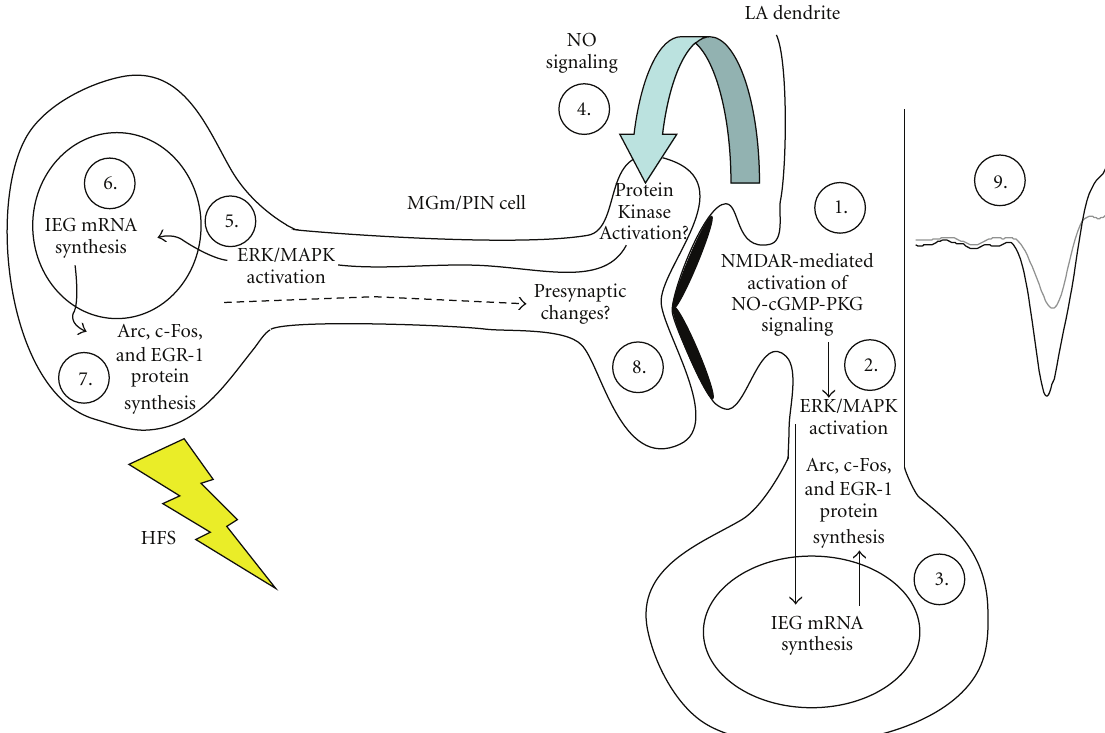
Figure 10: A model of the biochemical mechanisms underlying LTP at thalamo-LA synapses. See text for